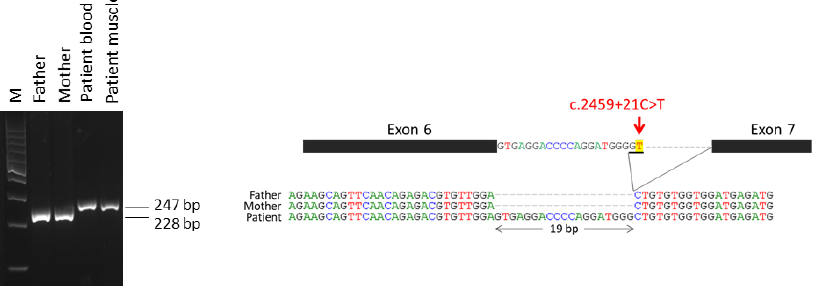
Figure 2. Variant effect on splicing in ND0673 patient. Conventional RT-PCR expression of IQSEC2 mRNA in peripheral blood samples from the patient and his parents, and patient muscle sample.